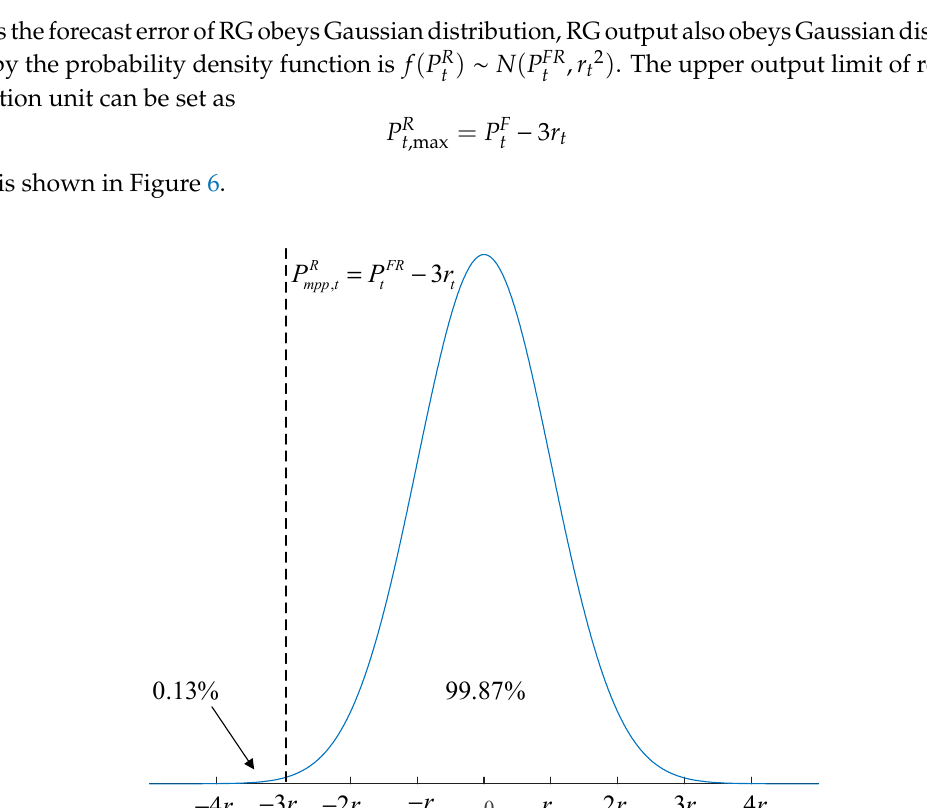
Figure 5. Curtailed IBG with fixed upper generation limit.